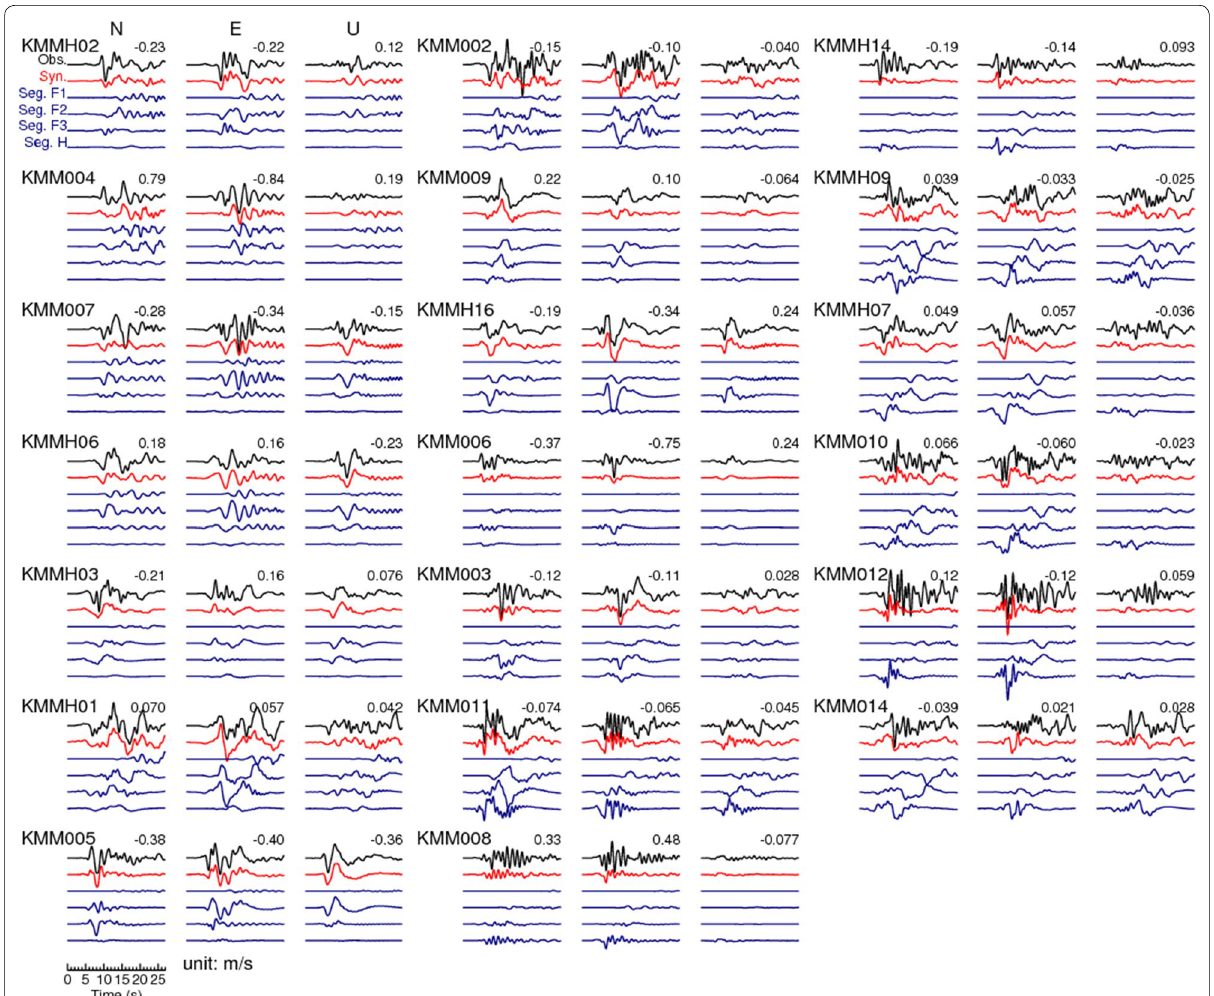
Fig. 6 Comparison of observed velocities (Obs., black ), synthetic velocities from the entire fault of the second inversion (Syn., red ), and synthetic velocities originating from each four segment ( blue ). The waveform is band-pass-filtered at 0.05–1.0 Hz. Segs. F1 , F2 , F3 , and H show the synthetic velocities calculated from respective segments, F1, F2, F3, and H. Borehole records of KiK-net, which are labeled similar to KMMH00 were